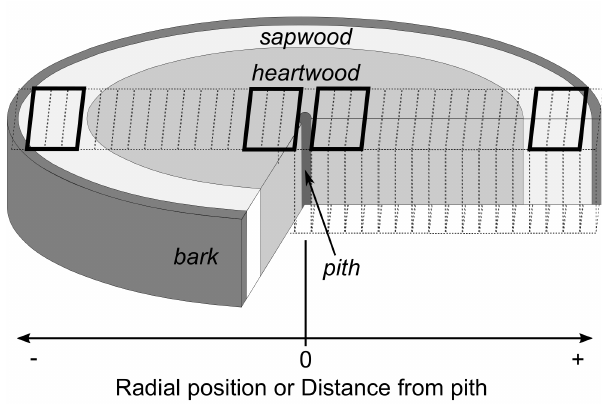
Figure 1. Schematic representation of wood disc showing the positions of the samples. Each diametric wood sample was divided into 0.5 cm tangential segments. Pith is contained in the central segment (i.e., radial position = 0). Each segment was also referenced regarding the type of wood (heartwood, sapwood, or both). The thick black lines show the position of clusters of samples used to establish the distribution of both inner and outer wood density (i.e., close to the pith and to the bark respectively).